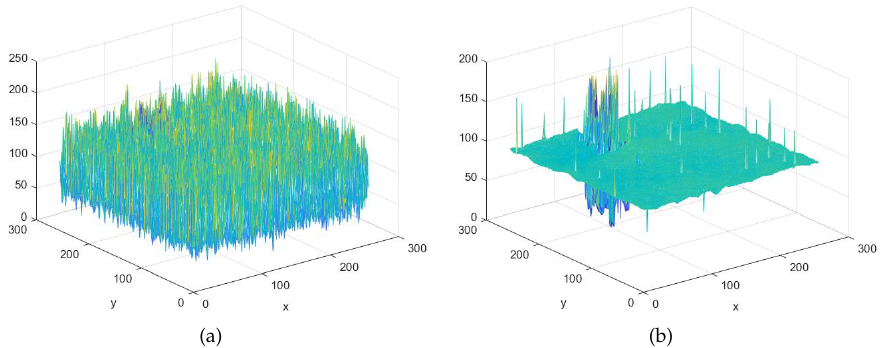
Figure 4. Implementation effect of the LGM. ( a ) Mesh diagram of fabric image; ( b ) Mesh diagram of smoothed fabric